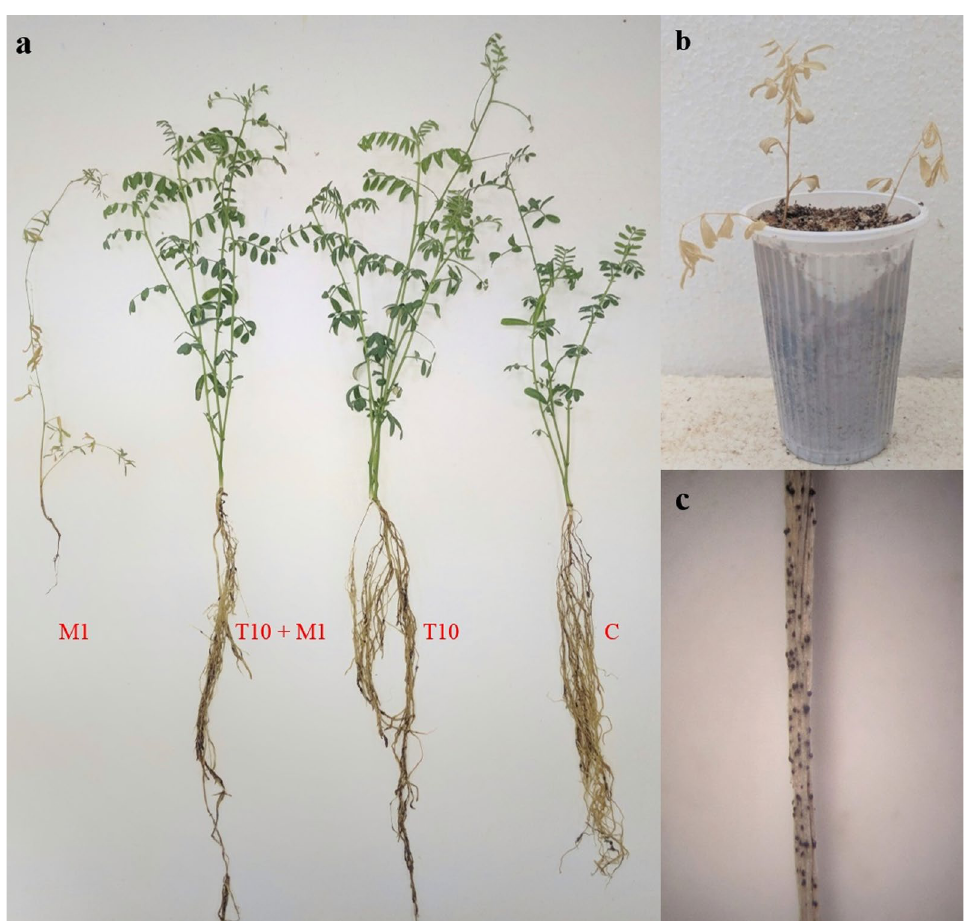
Fig. 5 Biocontrol efficacy of Trichoderma longibrachiatum species against Macrophomina. pseudophaseolina under greenhouse conditions. a In vivo test, b symptoms of charcoal rot (chlorotic foliage) on lentil plant, c colonization of lentil stem by the pathogen’s